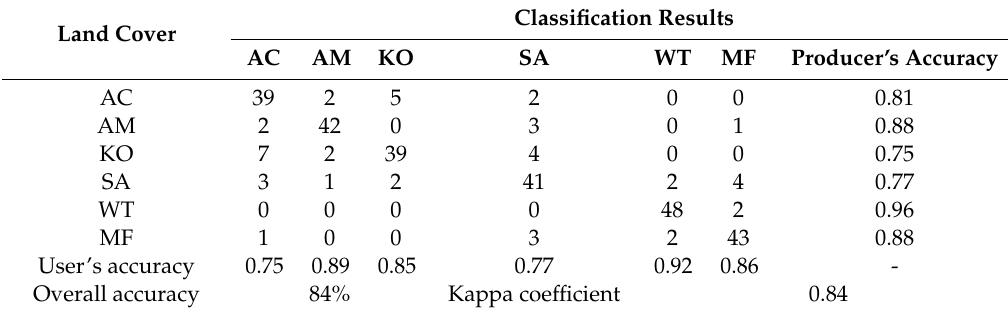
Figure 7. Phenology-based mangrove species map including the spatial distribution of different mangrove species and other types of land cover. Table 1. Confusion matrix, overall accuracy, producer’s accuracy, user’s accuracy, and Kappa coefficient for all classes. KO: Kandelia Obovata , AC: Aegiceras corniculatum , AM: Avicennia marina , SA: Spartina alterniflora , WT: water, and MF: mudflats.